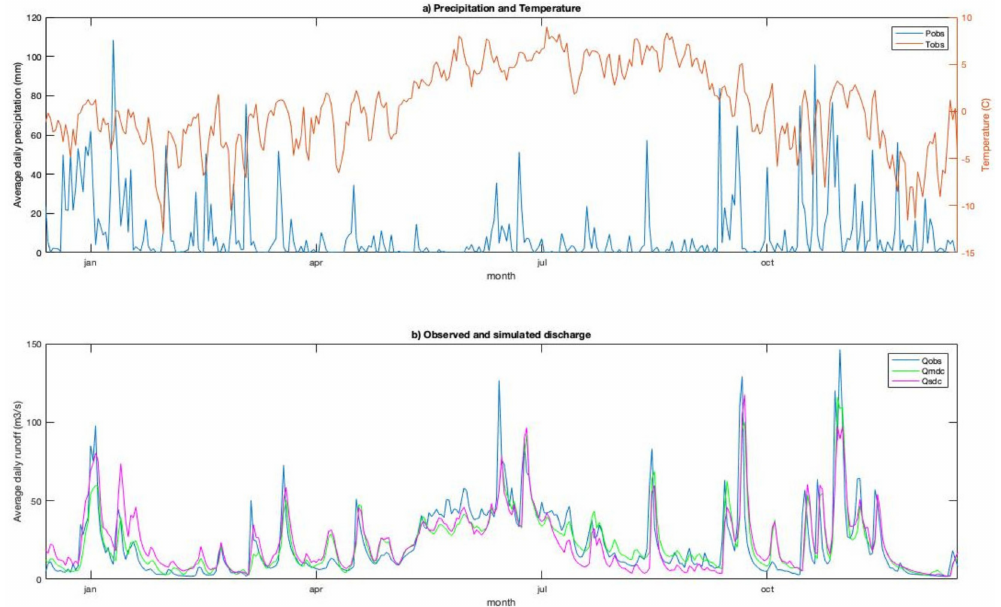
Figure 4. Observed precipitation and temperature, and observed and simulated discharge, during the validation period (2014). ( a ) Observed temperature and precipitation data from the Harmonie dataset [46]. ( b ) Observed and simulated discharge using single-dataset and multi-dataset calibration (MDC and